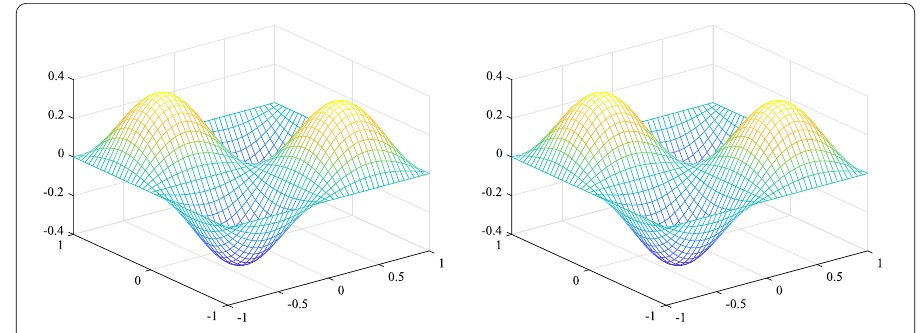
Figure 15 The numerical solution of CFDS6-SSM (left-hand side) and E-CFDS6-SSM (right-hand side) when J = 41, z = –0.4 and t = 1 for SP 5